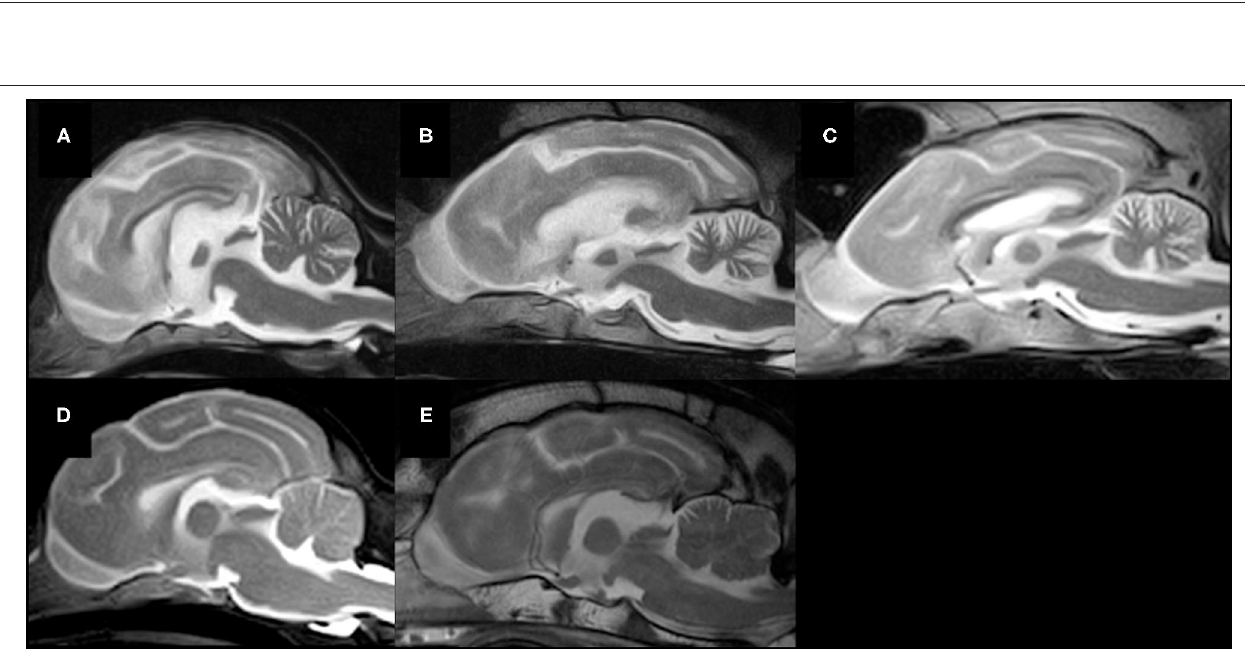
Frontiers in Veterinary Science | www.frontiersin.org